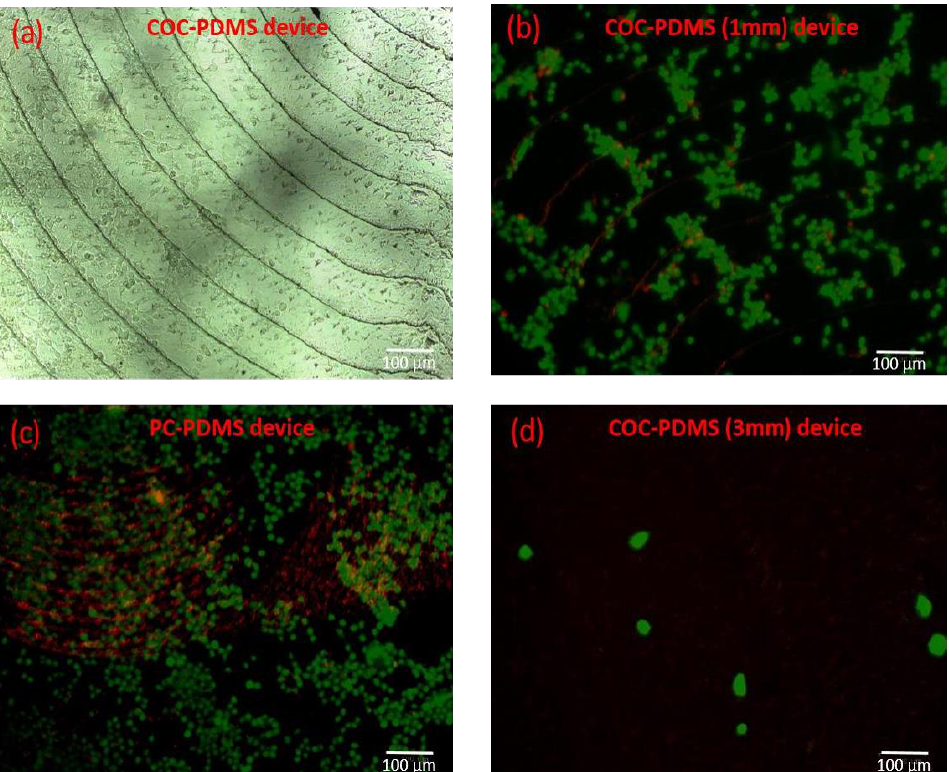
Figure 2. Microscopy images of the Huh7 hepatoma cell line cultured in the fabricated devices: ( a ) Optical image of Huh7 cells grown in the COC–PDMS device (Figure 1b) with a thickness of 1mm for 24 h. The image was taken by 10 × objective; ( b ) Live-dead cell imaging results from the COC–PDMS device with 1 mm thickness of the PDMS layer. Green (Calcein-AM)—live cells, red (Propidium Iodide)—dead cells. (no autofluorescence from the substrate); ( c ) Live-dead cell assay images on the PC–PDMS device (Figure 1a) resulting in autofluorescence from PC; ( d ) Live-dead assay imaging of the COC–PDMS device with 3 mm thickness of the PDMS layer. Experimental results showed a possible lack of oxygen through a thick layer of PDMS, resulting in almost zero cell viability. At low cell densities, cells tend to change morphology; therefore, cells seem visibly bigger in size on this